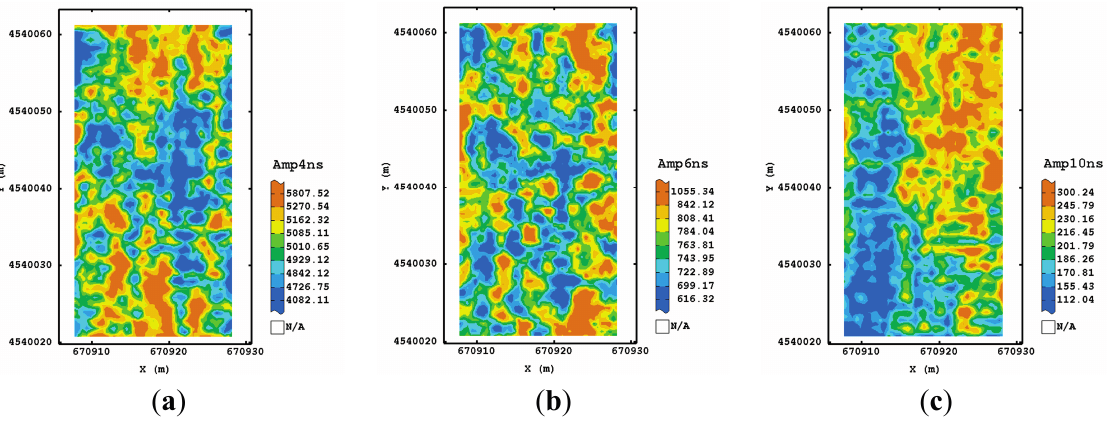
Figure 7. Maps of estimated amplitude for 250 MHz antenna frequency using the third processing procedure corresponding to 4 ns ( a ); 10 ns ( b ) and 20 ns ( c ). (Colour scale uses iso-frequency classes).